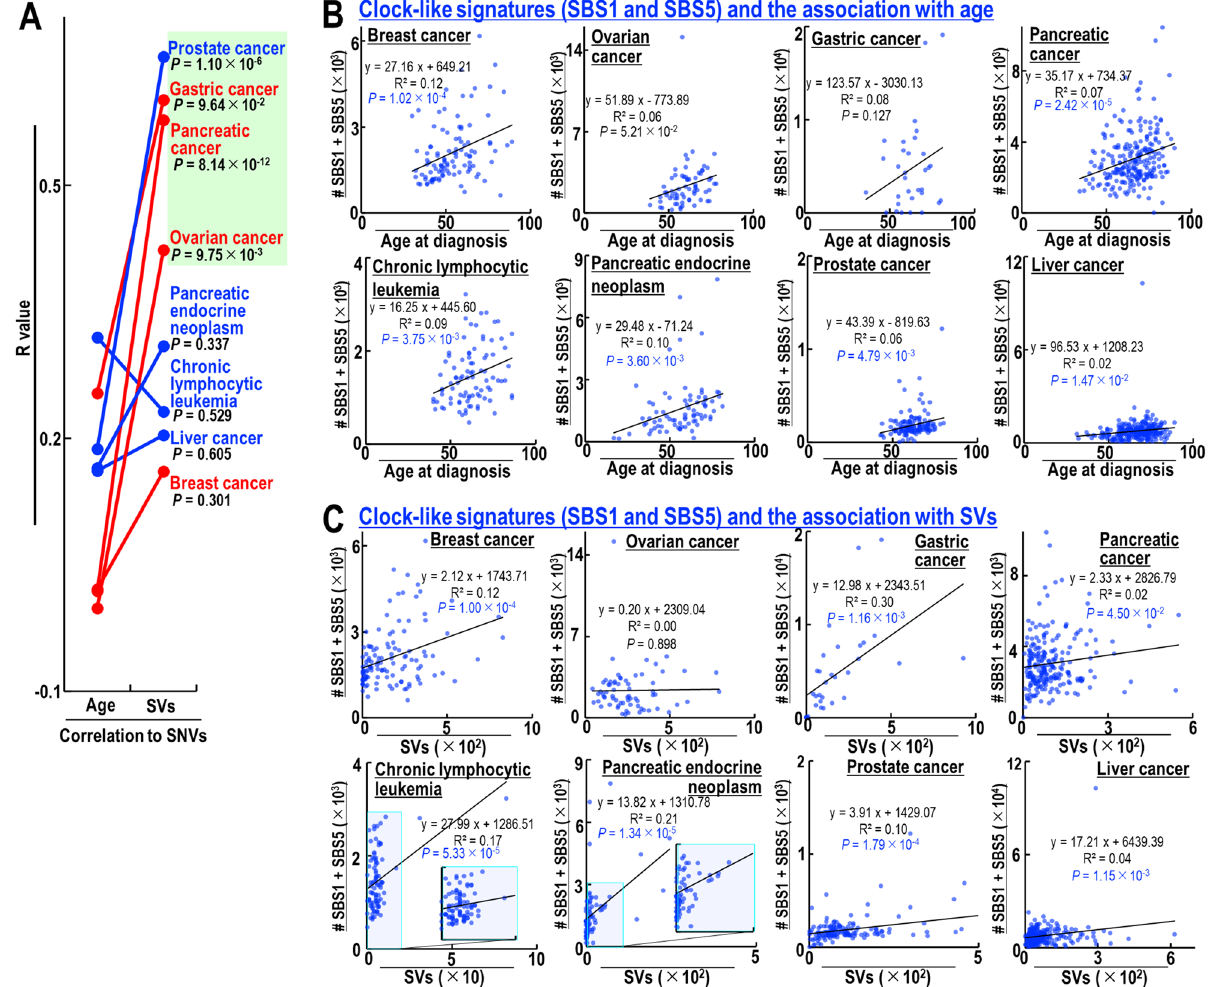
Figure 2. Correlated inductions of SNVs and clock-like signatures with SVs. ( A ) Comparisons of R-values (i.e., sample correlation coefficients) between SNVs and age at diagnosis and R-values between SNVs and SVs in each type of cancer. Statistical analyses by two-tailed Z-tests. ( B , C ) Correlations between numbers of clock-like signatures (i.e., SBS1 plus SBS5) and age at diagnosis ( B ) and numbers of SVs ( C ). Statistical analyses by two- tailed t